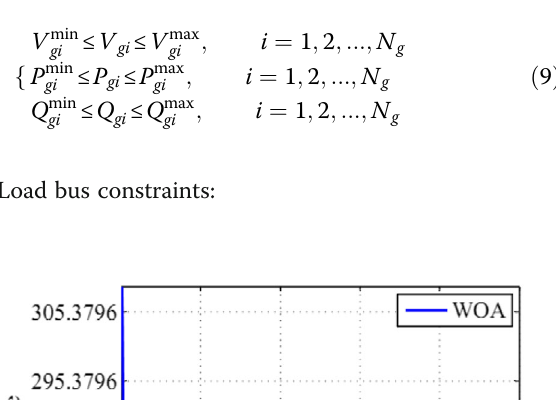
Fig. 9 Topology of the Algerian 114-bus power system [45]